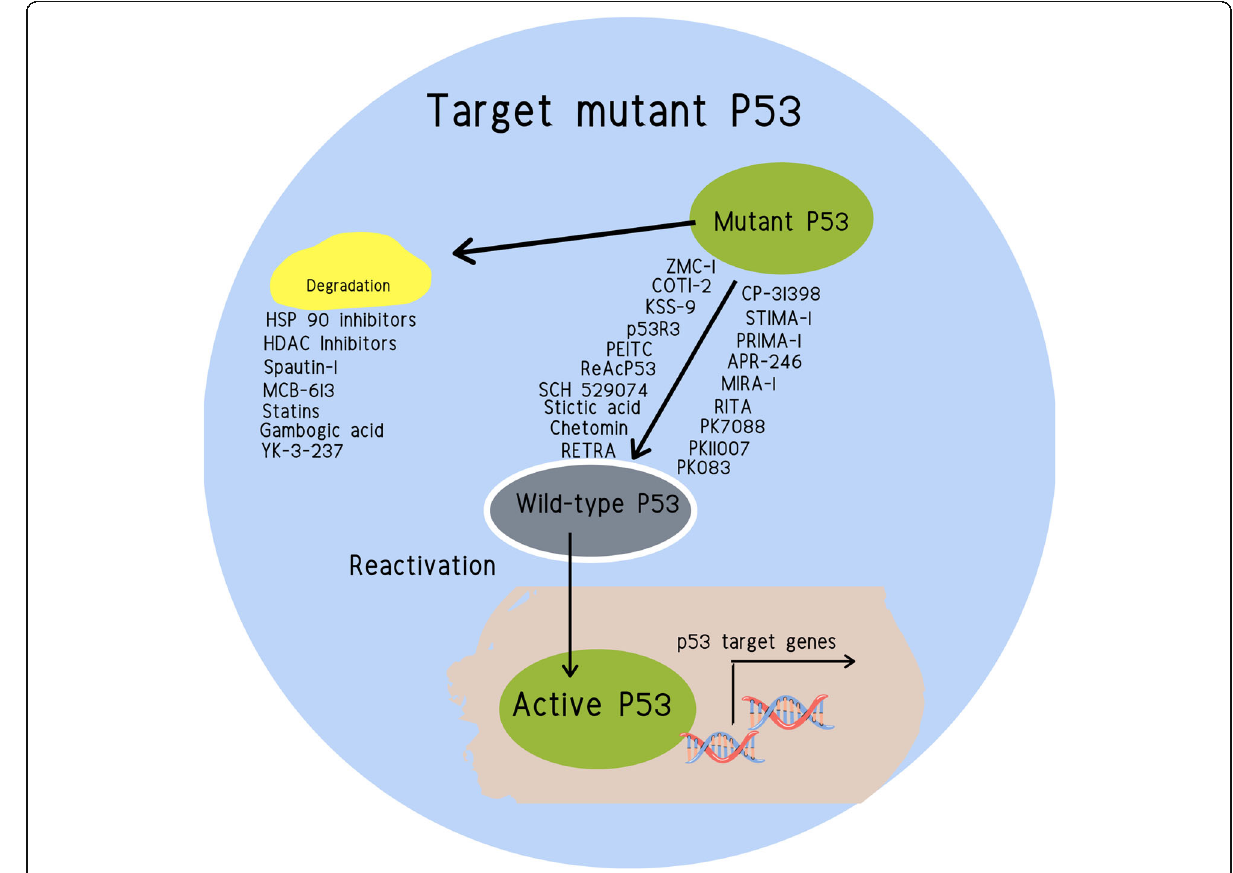
Fig. 3 Strategies to target mutant P53 in cancer cells